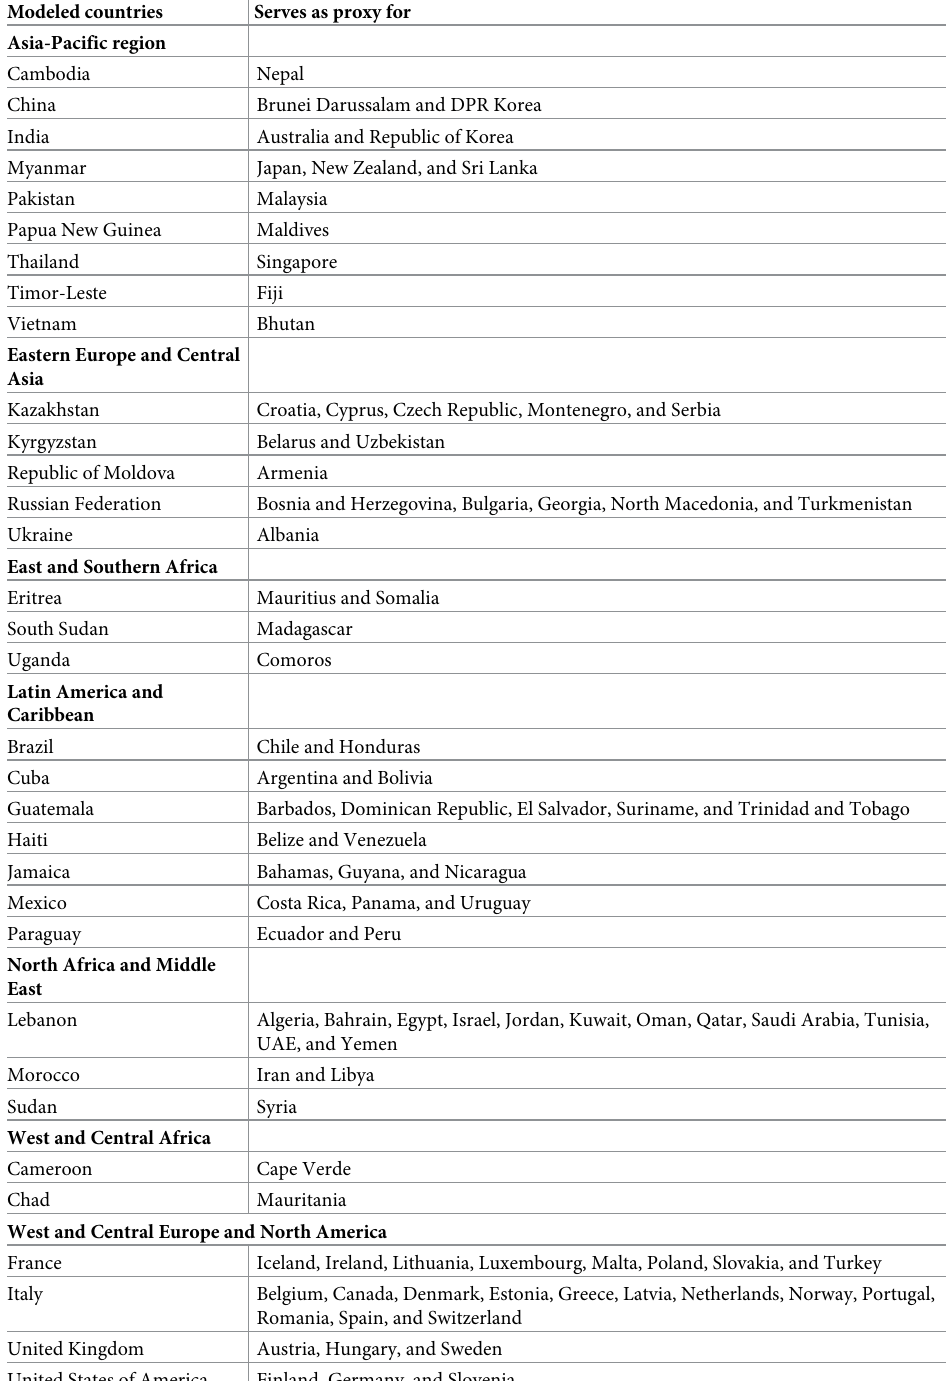
Table 2. Countries modeled using a proxy country. Modeled